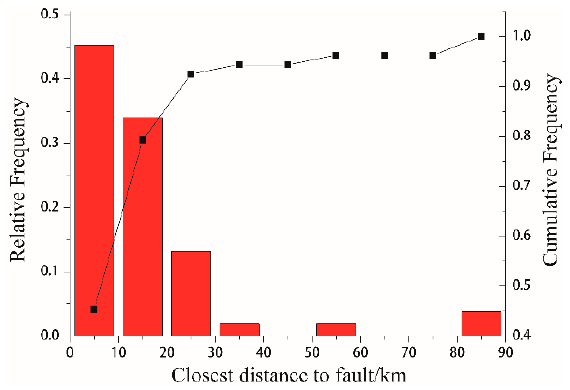
Figure 13. The relative frequency distribution of the closest distance-to-fault, for the 53 sets of seismic motions, qualified as pulse-like motions.